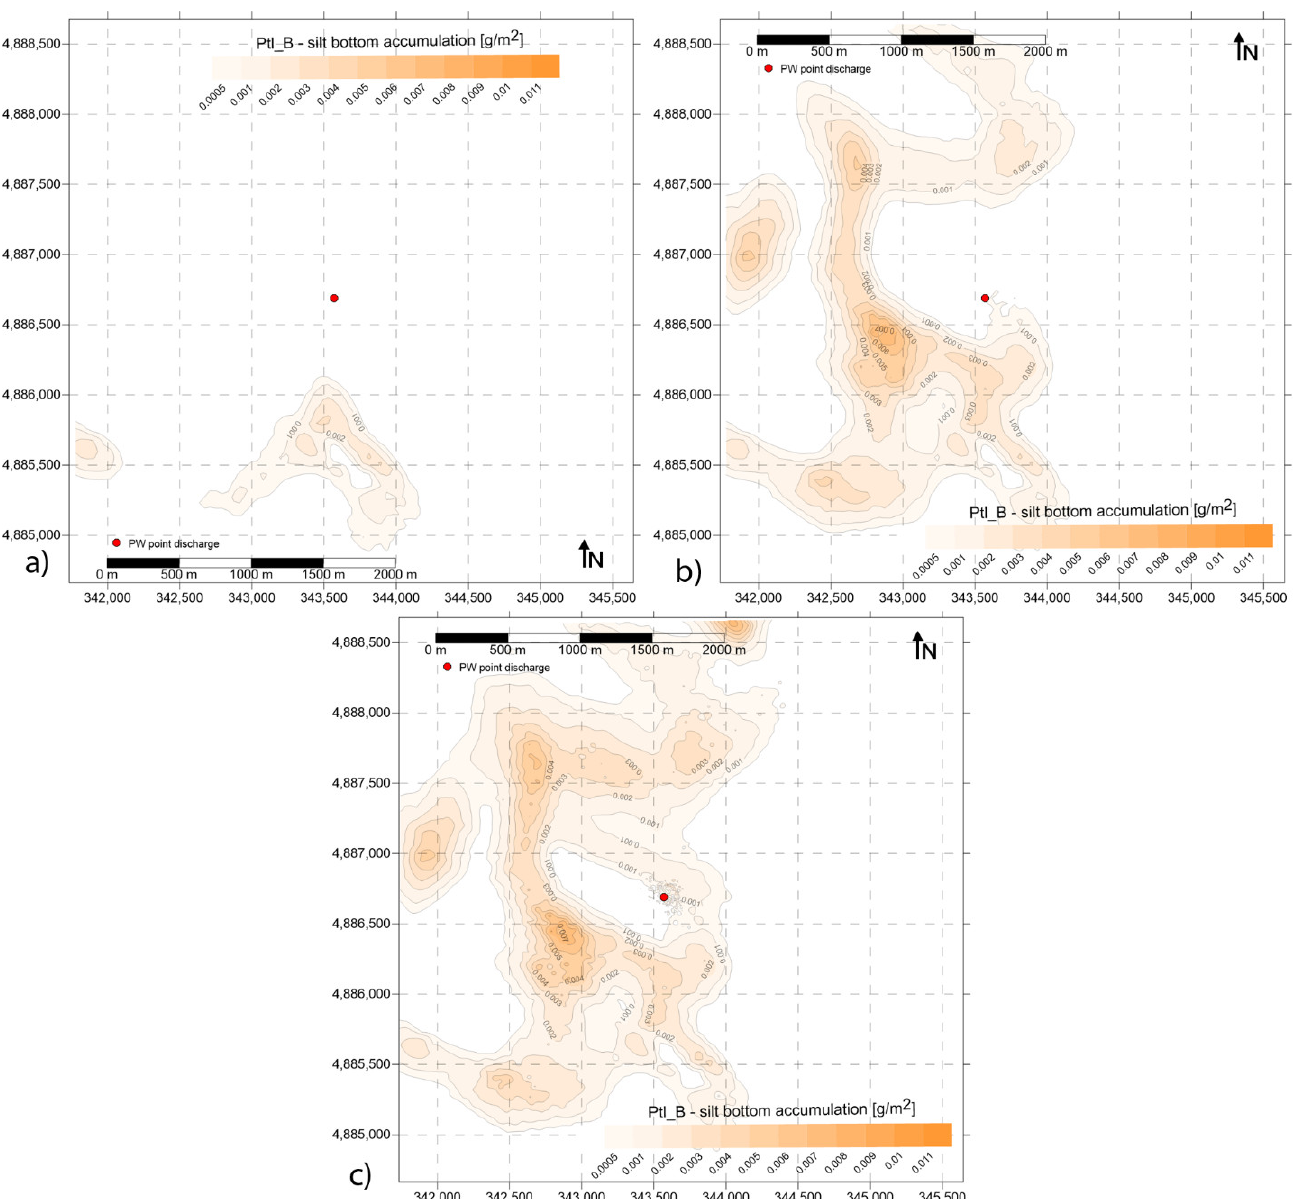
Figure 12. Map (WGS 84 UTM 33N) of silt bottom accumulation ( a ) after 10 days, ( b ) after 20 days, and ( c ) after one month as result by MIKE 3 PT module output for Plt B (red dot).